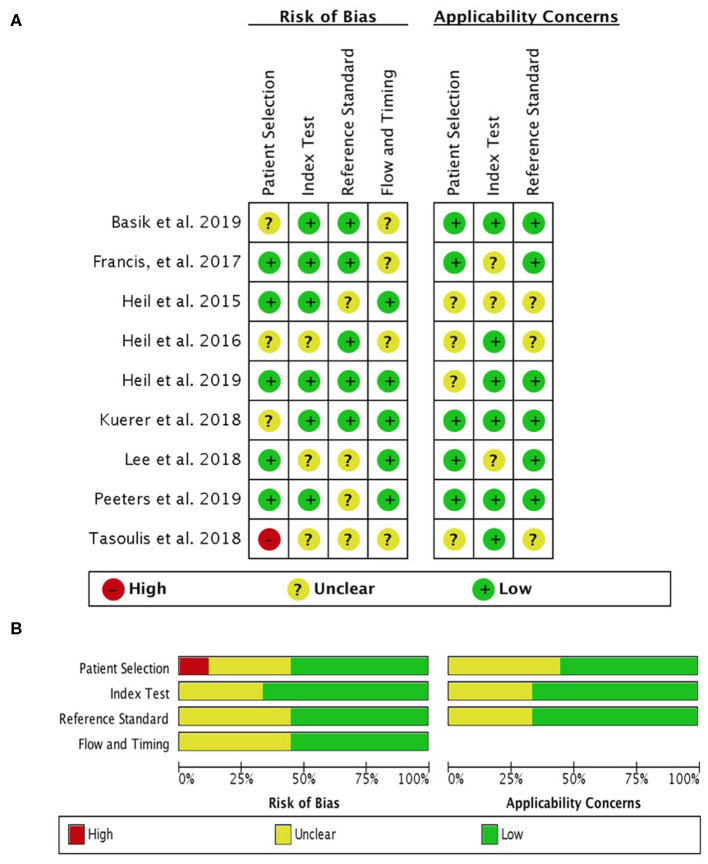
Evaluation of risk of bias by QUADAS-2 tool. (A) Risk of bias graph and (B) risk of bias summary.